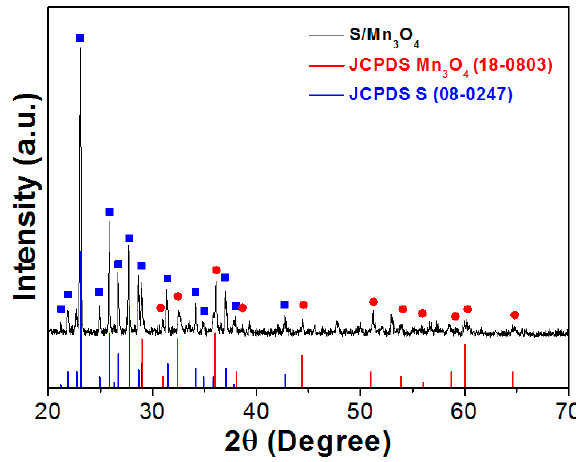
Figure 1. XRD patterns of S/Mn 3 O 4 .